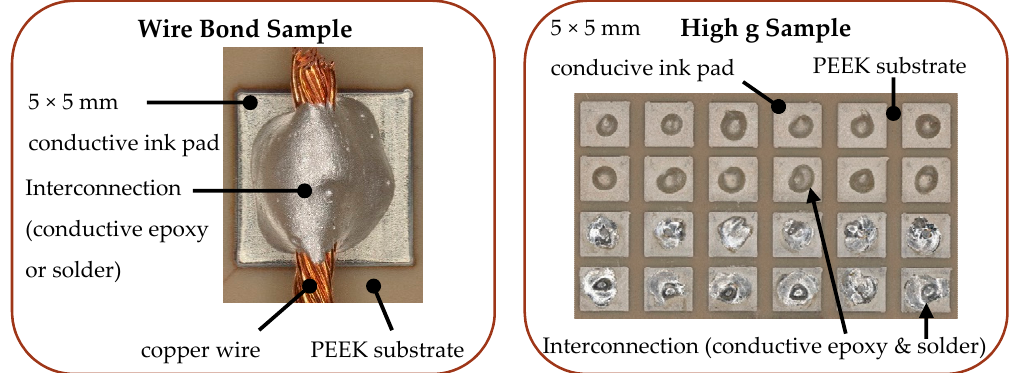
Figure 1. Diagrams of wire bond pull ( left ) and high g ( right ) electrical interconnection samples.